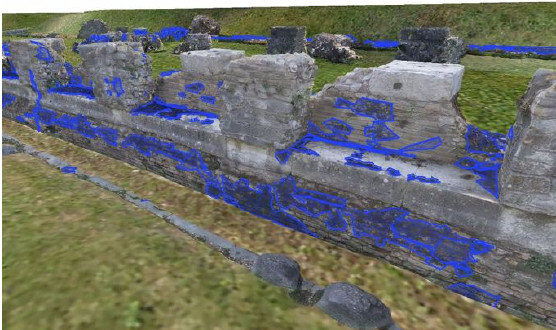
Figure 9. Example of a segmented area of the Roman river port of Aquileia (segmentation code